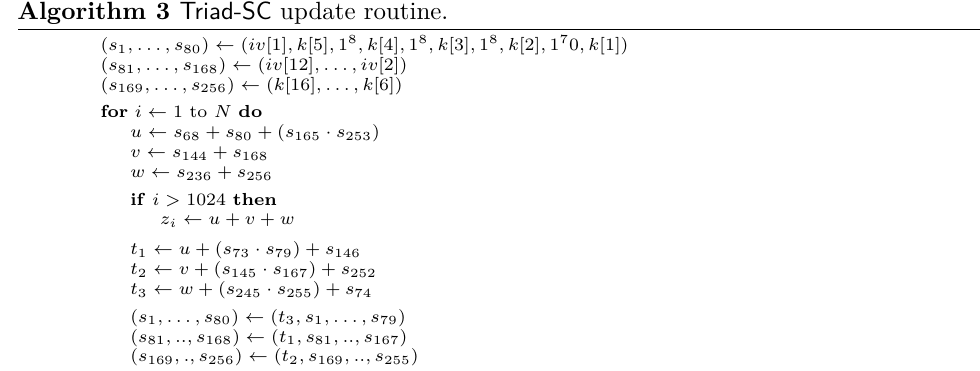
Algorithm 3 Triad-SC update